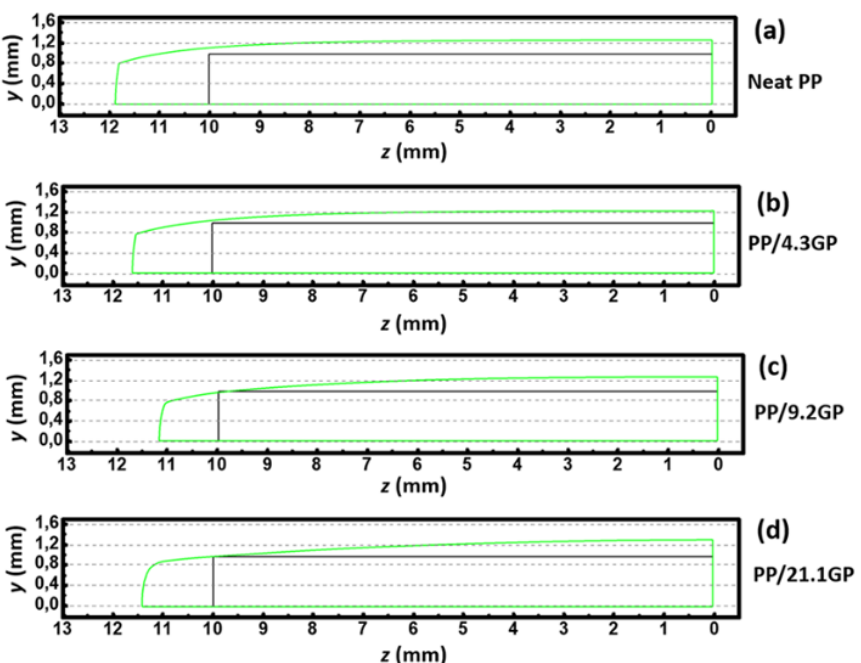
Figure 9. Profiles of the extrudate at a flow rate of 620 mm 3 s − 1 of PP melt with various filler contents at the flow distance of 40 mm after the die exit: ( a ) neat PP, ( b ) PP/4.3GP, ( c ) PP/9.2GP, ( d ) PP/21.1GP. Black curves indicate the shape of the slit die while the green curves represent the equilibrated extrudate profiles (one fourth shown due to